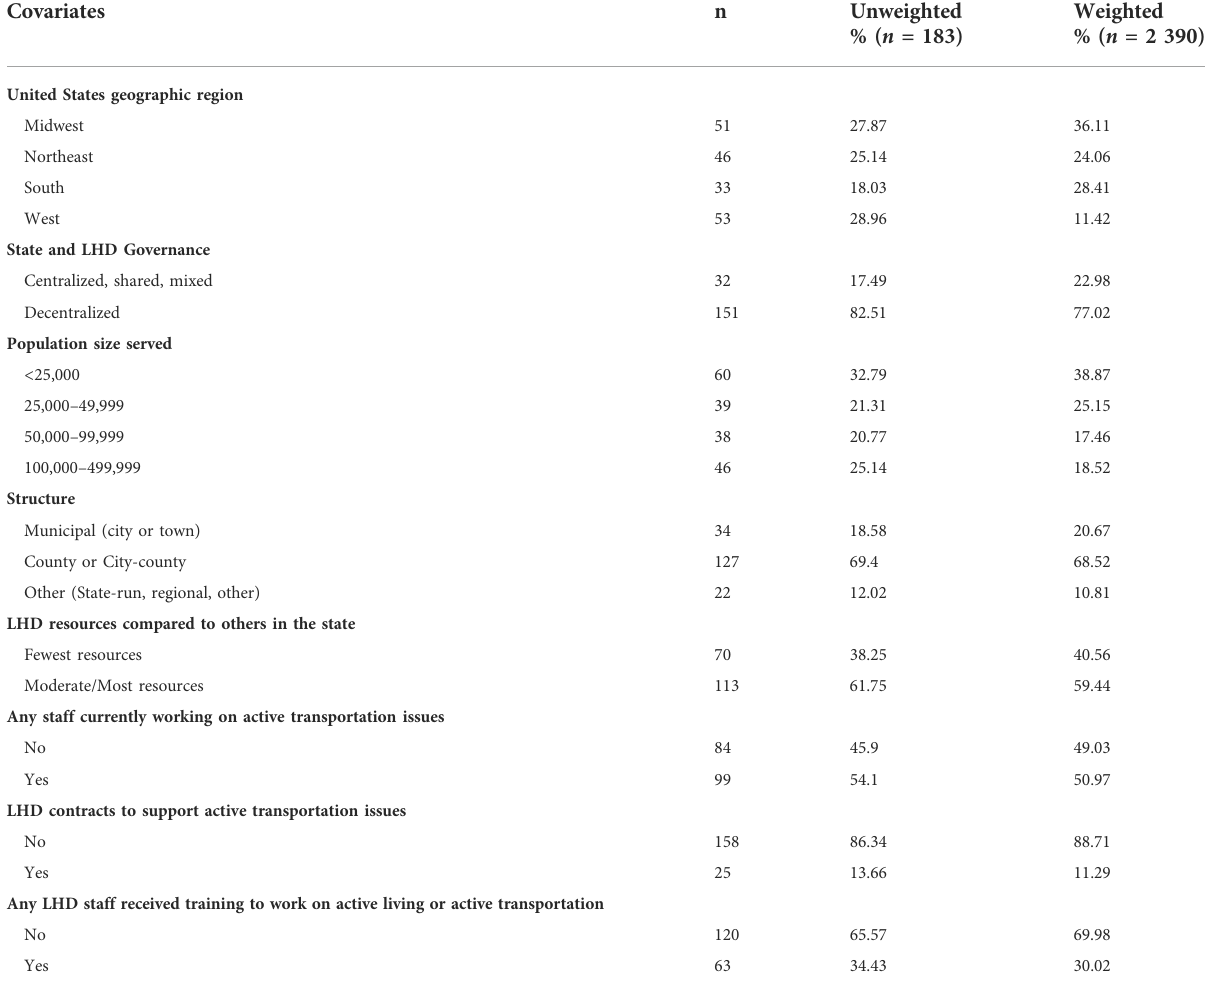
TABLE 1 Local health department characteristics, n = 183.